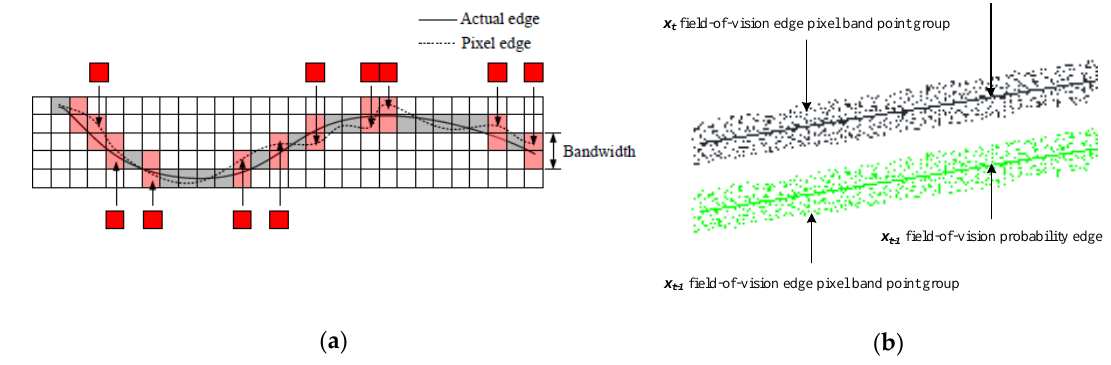
Figure 4. Schematic diagrams of edge pixel band point groups and probability edges: ( a ) pixel-level edges; ( b ) holographic probability edges.